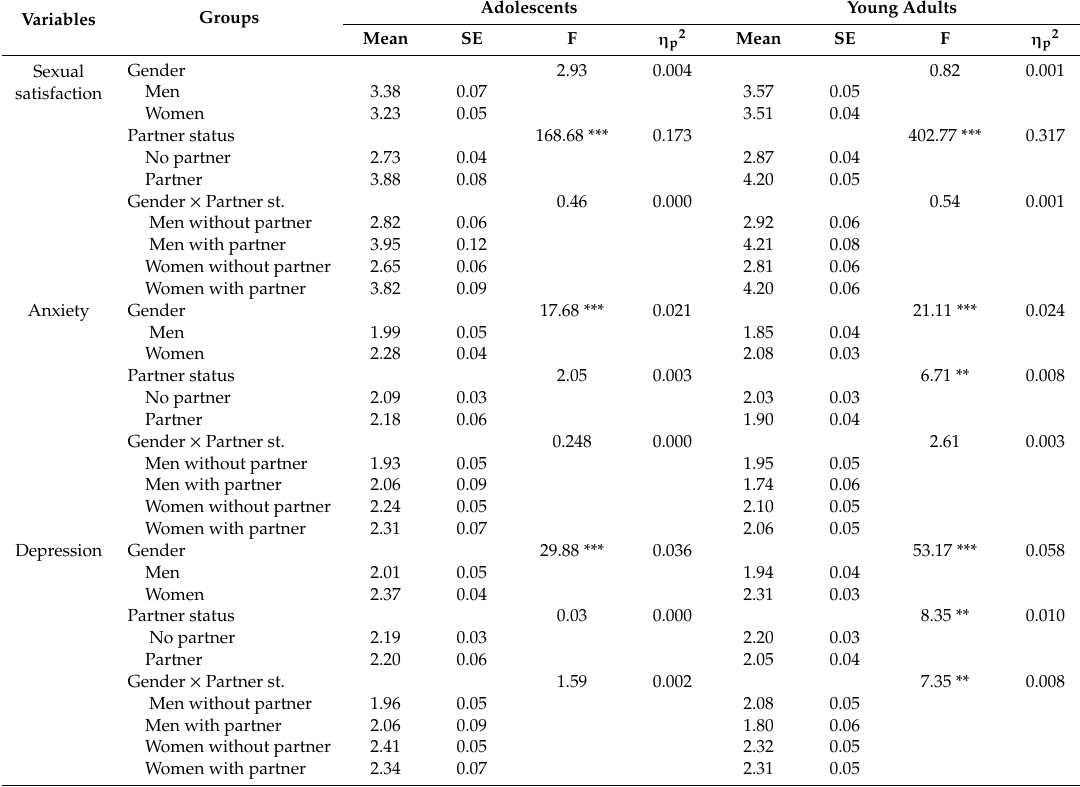
Table 1. Univariate ANOVA results for di ff erences in sexual satisfaction and mental health among sexual activity level and partner status groups for adolescents and young adults. Adolescents Young Adults Variables Groups Mean Sexual